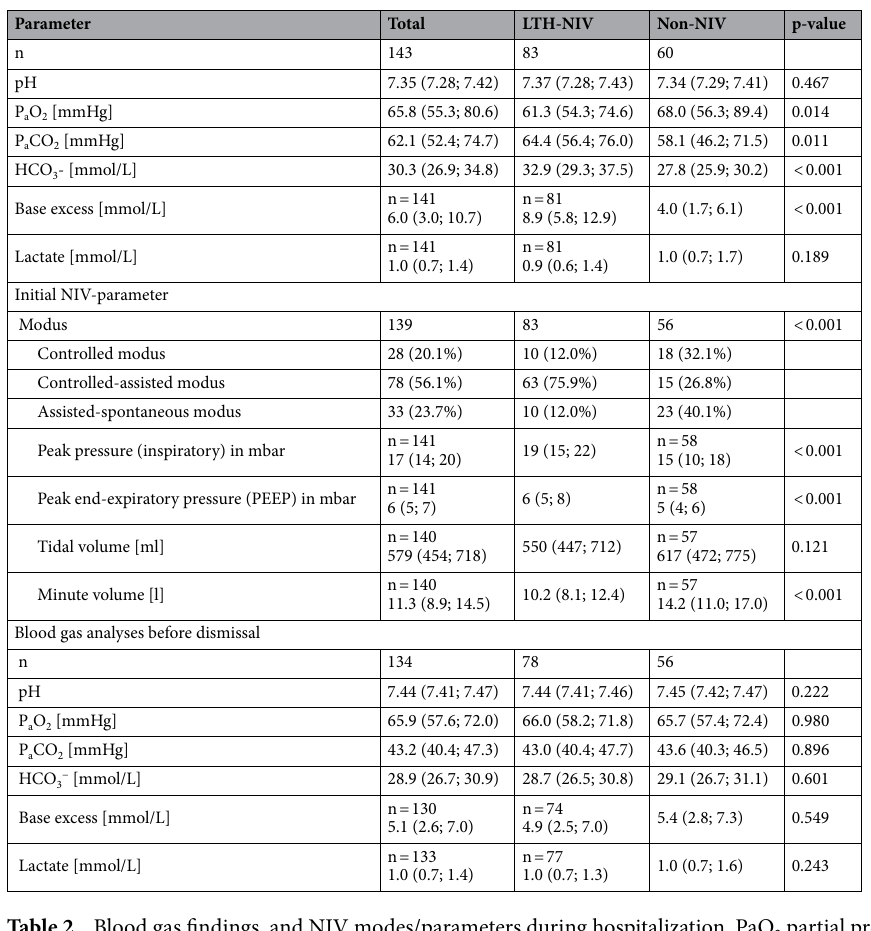
drop in pH (p < 0.001) and a significant increase in P a CO 2 values (p = 0.001), but no significant difference in bicarbonate values (0.471). The need for hospital readmission in the event of clinical deterioration showed no significant (p = 0.233) difference between the two groups during the two-year observation period. Survival. During the observation period, 23 out of 83 (27.7%) of the patients in the LTH-NIV group and 27 out of 60 (45.0%) of the patients in the non-NIV group died (Fig. 4). Accordingly, the 1- and 2-year survival rates